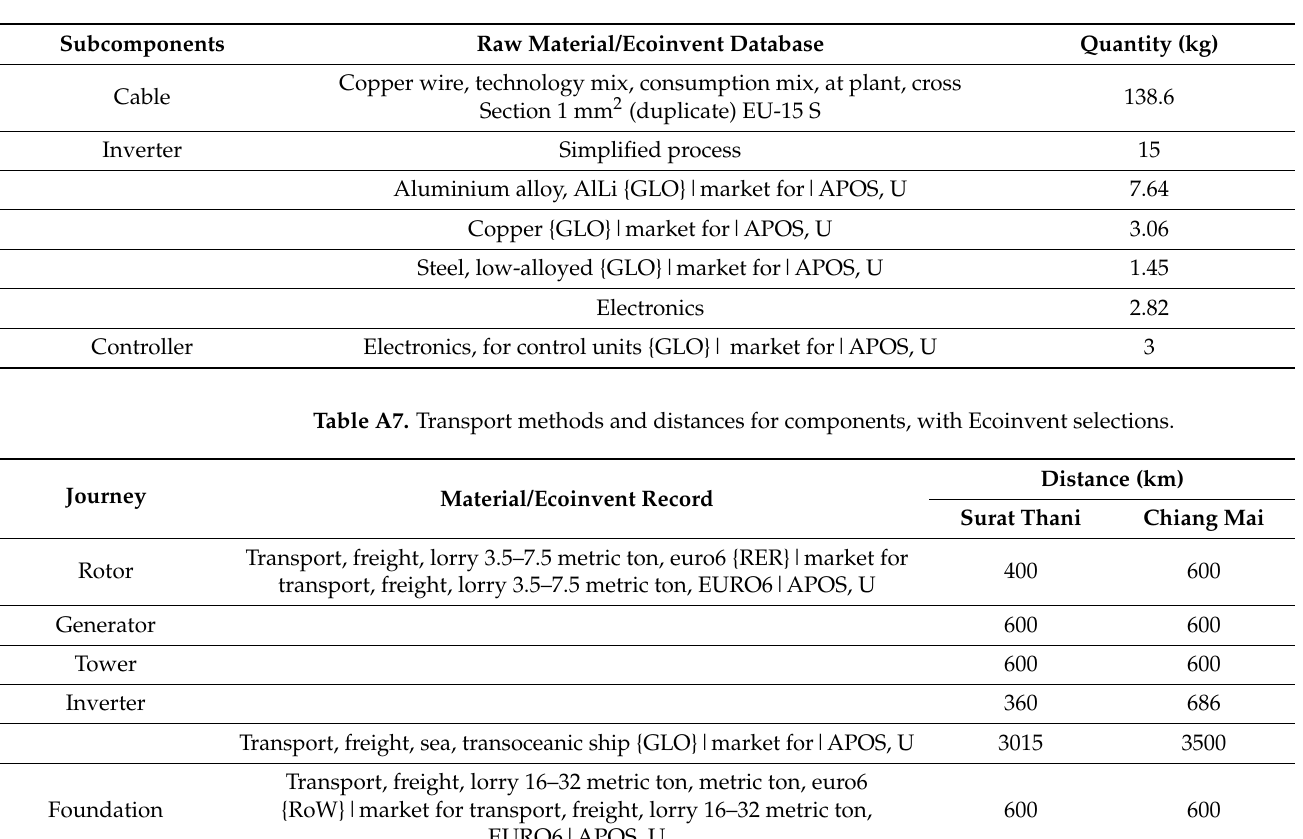
Table A6. Electrical connection inventory and matching Ecoinvent records.